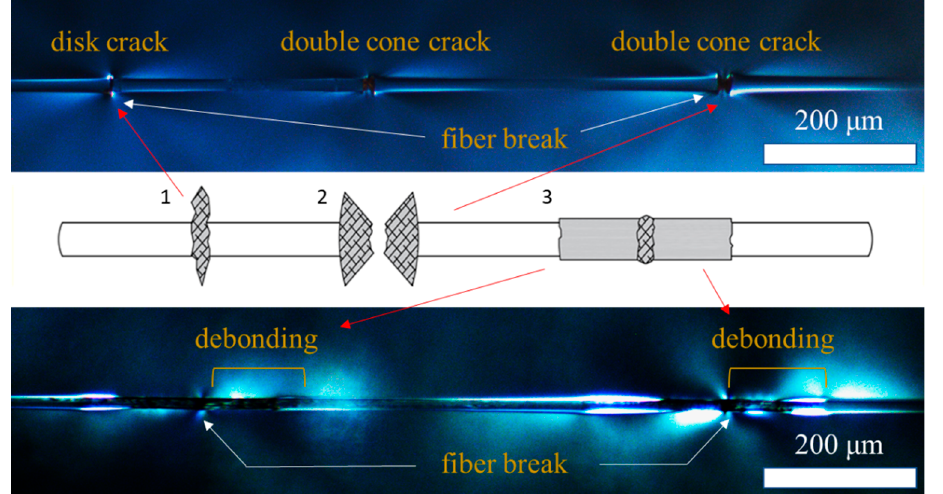
Figure 6. Interfacial fracture modes observed in single fiber fragmentation. (1) Disc-shaped matrix cracking indicates strong interface. (2) Double cone matrix crack represents intermediate interface strength. (3) Matrix debonding along the surface of the GF indicates a weak interface.